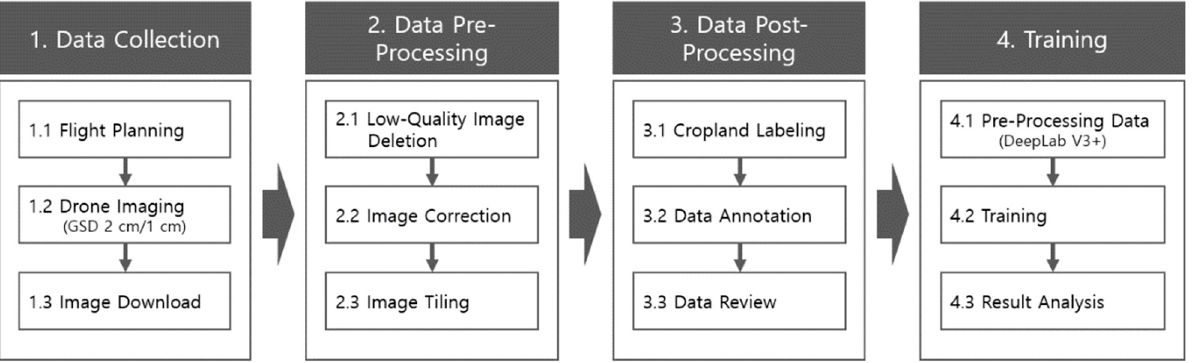
Figure 5. Learning data construction process.